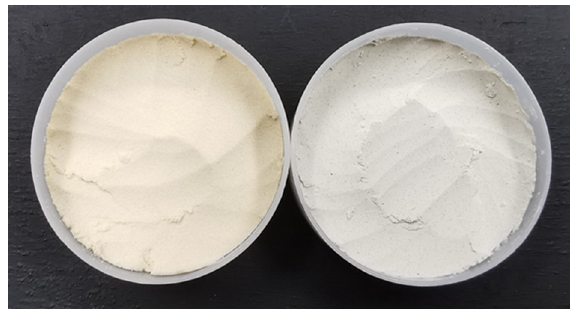
Figure 2. Soy protein isolate (left); and hemp protein concentrate (right) powder.